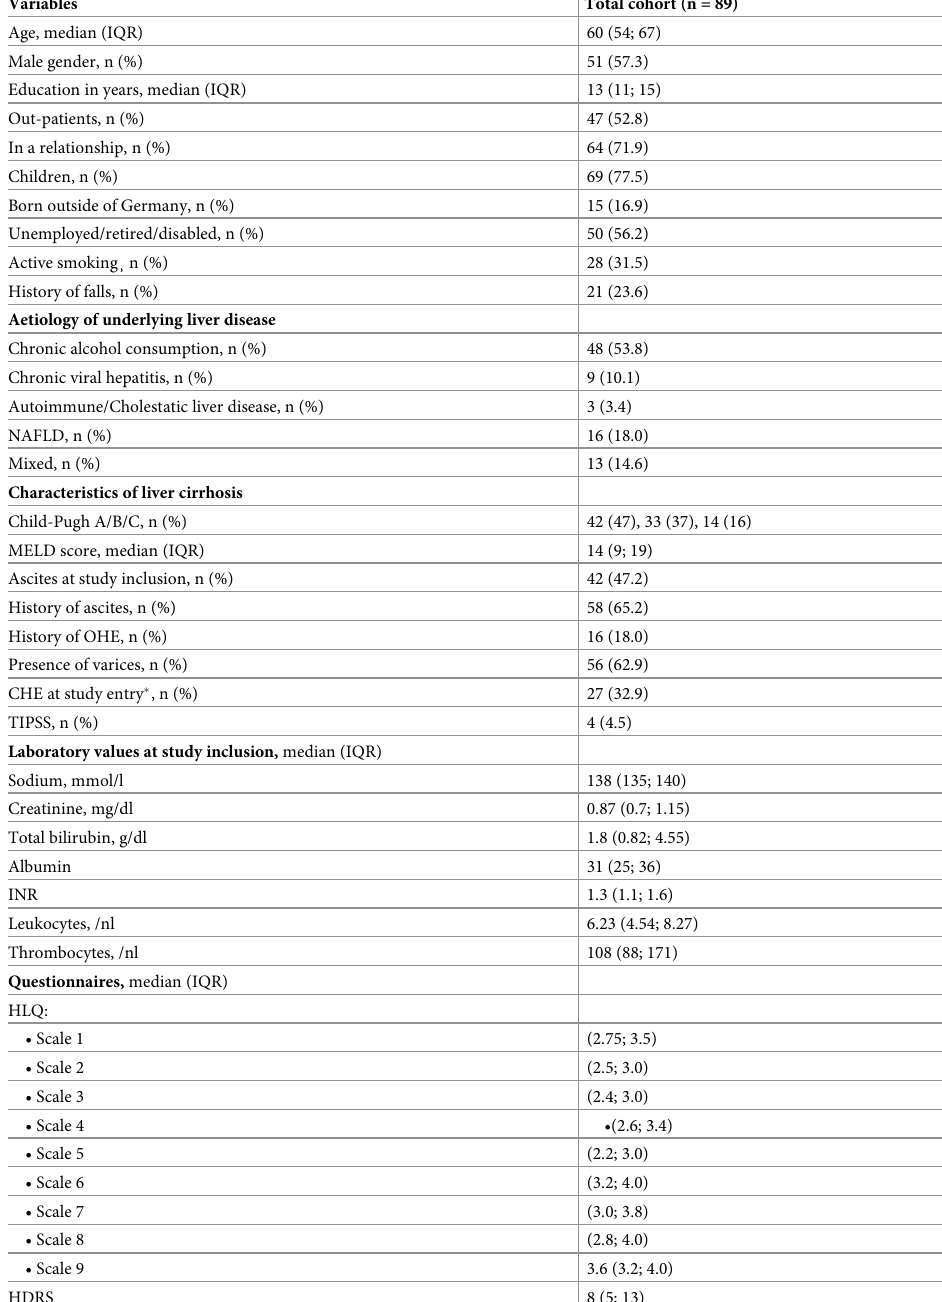
Table 1. Baseline characteristics of the entire cohort at study